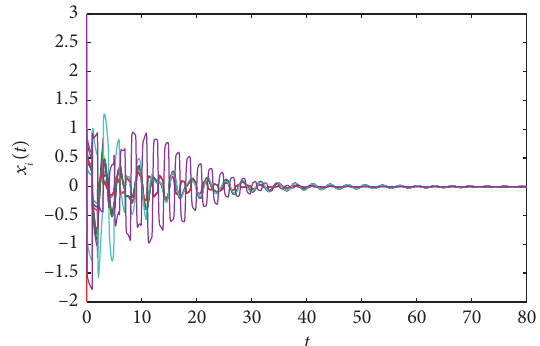
Figure 2: States of fuzzy neural networks (8) with pinning control: z